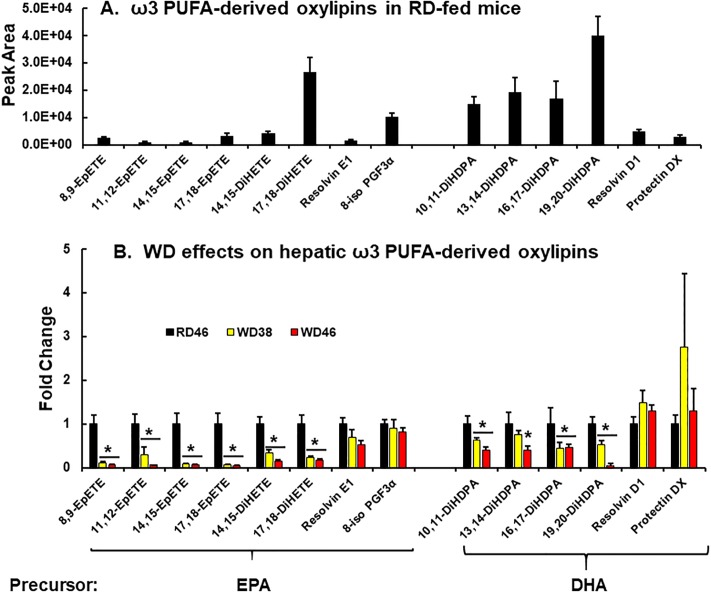
Western diet effects on hepatic ω3-PUFA derived oxylipins.ω3 PUFA derived oxylipins were quantified using a un-targeted LC/MS approach (Materials and methods)s. A: ω3 PUFA-derived oxylipins in RD-fed mice. B: Diet effects on ω3 PUFA-derived oxylipins. Results are presented as fold change in oxylipins induced by the WD. (mean ± SEM, N = 7–8 samples), *, FDR <0.05 versus the RD46 group. EpETE, epoxyeicosatetraenoic acid; DiHETE, dihydroxyepoxyeicosatetraenoic acid, DiHDPA, dihydroxy docosapentaenoic acid; PGF3α, prostaglandin F3α; EPA, eicosapentaenoic acid; DHA, docosahexaenoic acid.